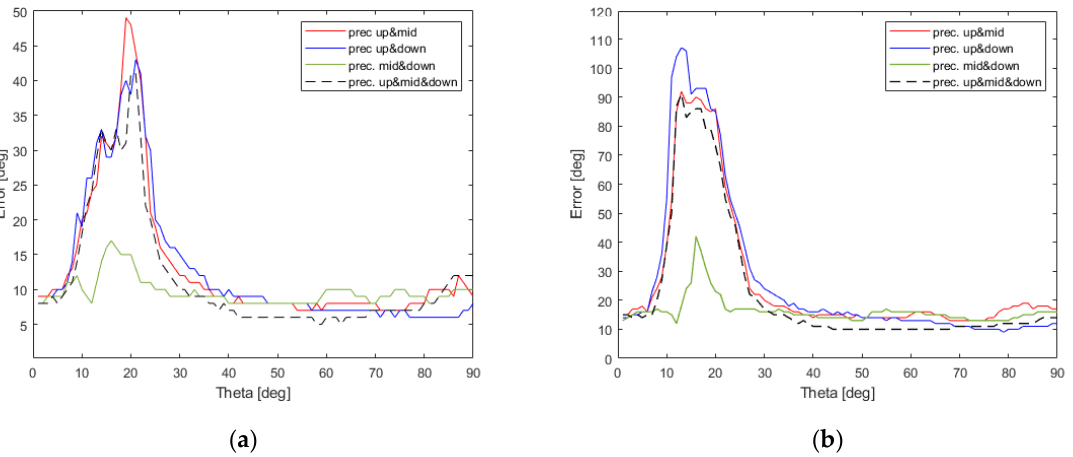
Figure 13. Comparison of precision values obtained using the proposed detailed DoA testing method and the combinations of steering vector sets giving the most accurate results for different SNR levels: ( a ) SNR = 5 dB ( b ) SNR = 0 dB.